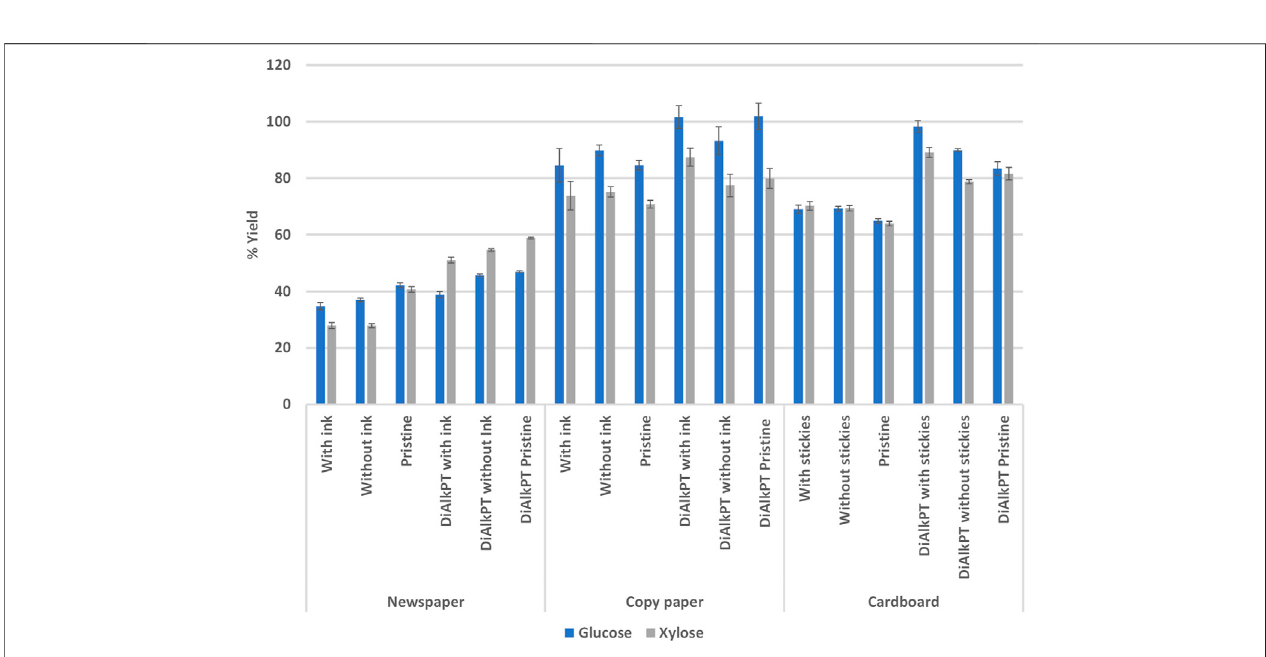
FIGURE 7 | Enzymatic hydrolysis yields were not impacted by the presence of ink and stickies. DiAlkPT, dilute alkaline pre-treated.